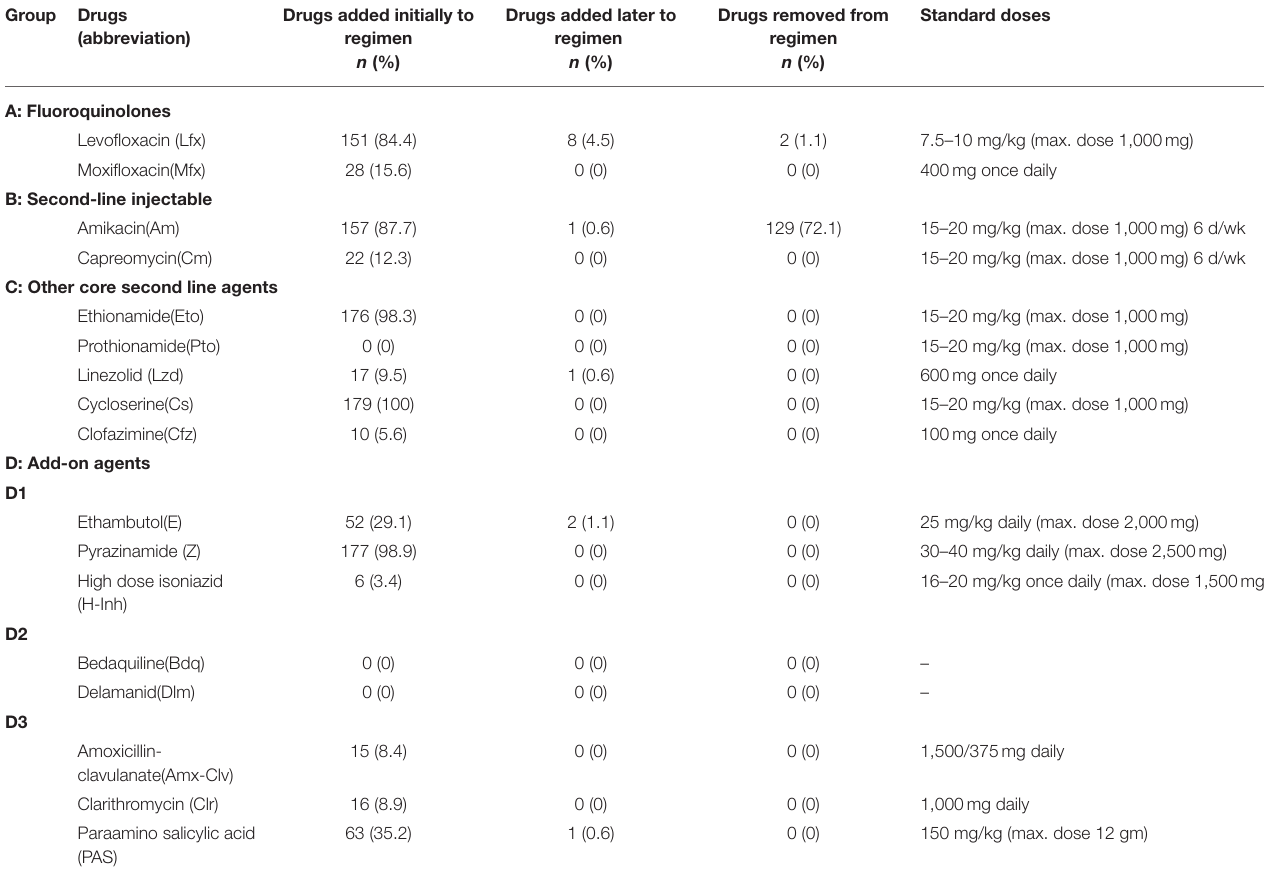
TABLE 3 | Treatment regimen of the patients ( n = 179). Group Drugs (abbreviation)